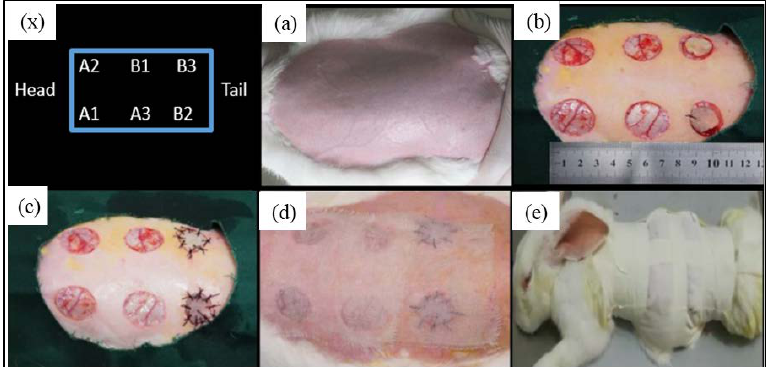
Figure 4. ( a – e ) The operation procedure of skin wound repairing; X is the schematic diagram of sample placement position: A1 refers to SC4:1 hydrogel skin membrane; A2 and A3 refer to SC4:1 with growth factor; B1 is a blank control; B2 and B3 are the autologous skin controls. For the SC skin scaffold groups (A1, A2, and A3), after the first week (Figure 5), all wounds shrunk significantly, with a diameter of about 1.5 cm. Most of the hydrogel samples at positions A1, A2, and A3 were still sticking to the wound surface, which is similar to “skin crust” with a dark, yellowish-brown color and dry surface. After 2 weeks, the diameter of scar tissue reduced to about 1 cm with varying degrees of scab. After 3 weeks, the scars shrunk to about 0.5 cm, while the color of all wounds was closer to the normal skin than before, the shape of the scars was irregular, and back hairs grew more than half locally.